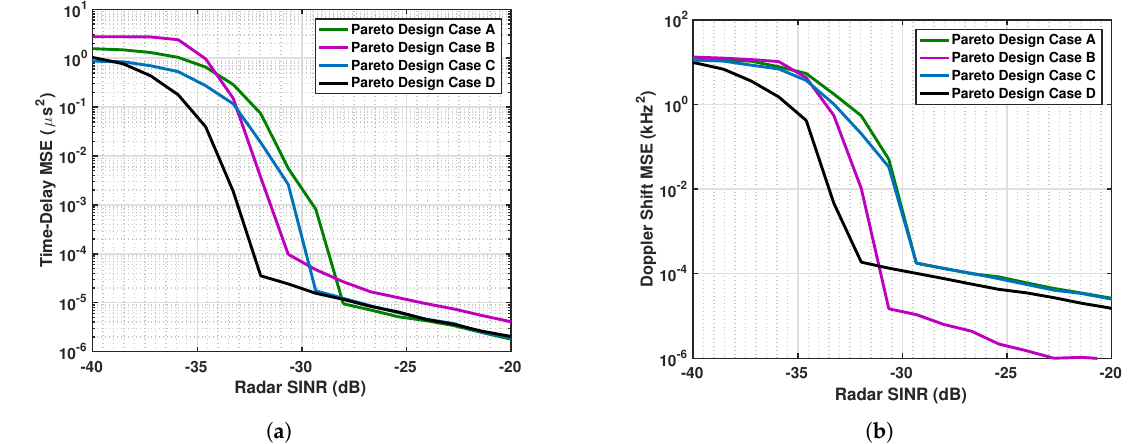
Figure 12. ( a ) Time-delay MSE and ( b ) Doppler estimation MSE performance for the Pareto designs that correspond to the four Pareto frontier ponts in Figure